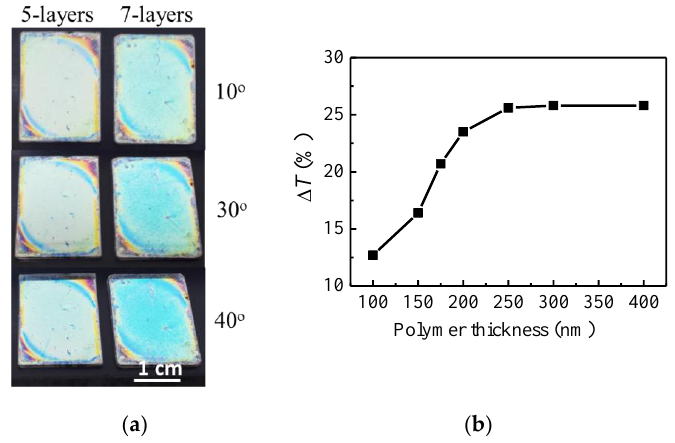
Figure 7. ( a ) Pictures of 5- and 7-layer Bragg stacks covered with polymer film with thicknesses of 300 at three viewing angles—10, 30, and 40 degrees; ( b ) calculated humidity-induced change of transmittance, Δ T , of 5-layer Bragg stacks covered with polymer film with different thicknesses.